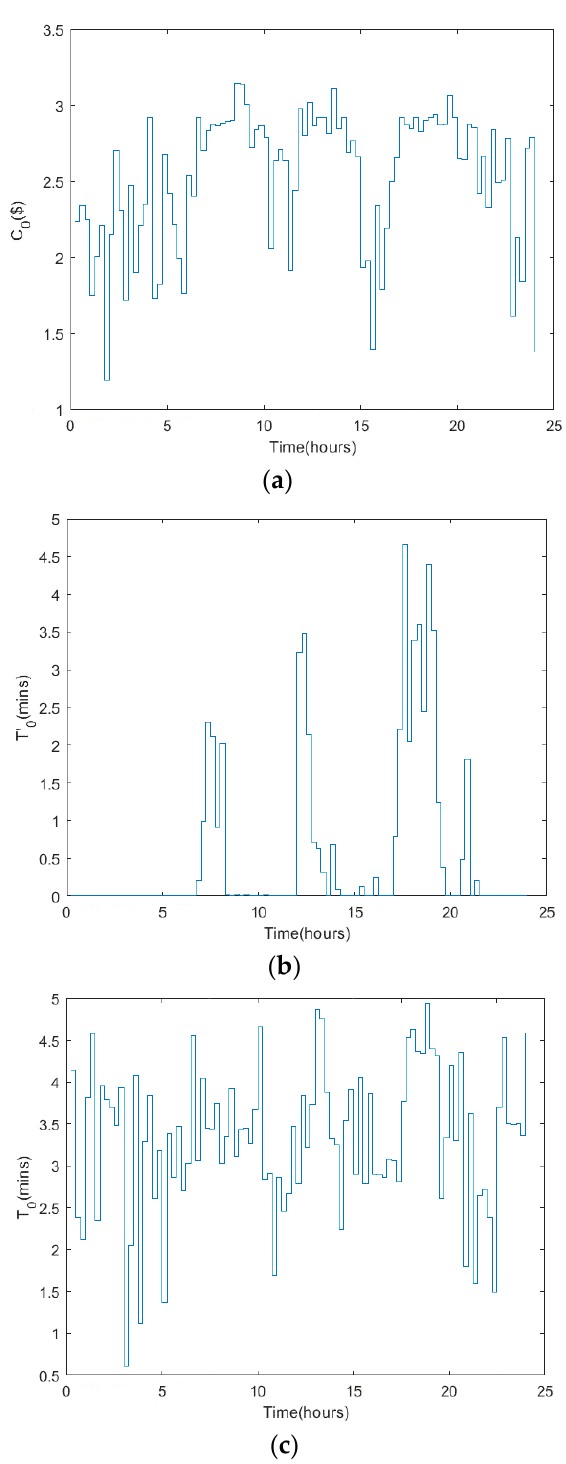
Figure 12. ( a ) Reference point of price; ( b ) Reference point of queue time; ( c ) Reference point of travel time.